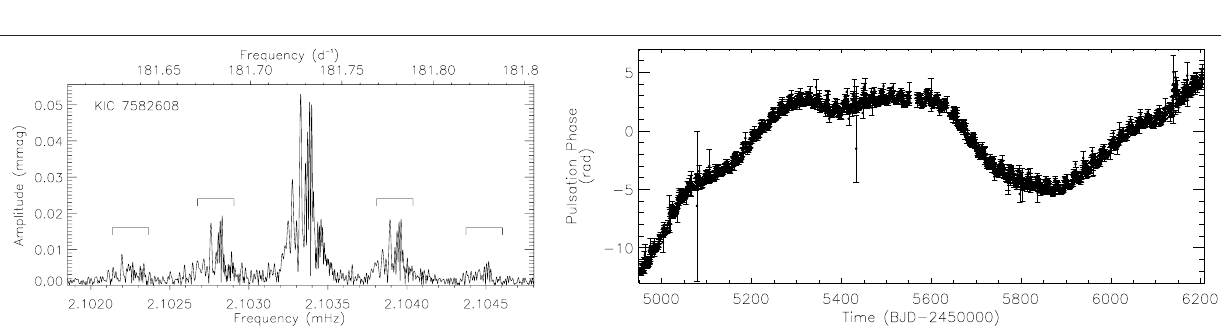
FIGURE 1 | HR diagram showing the location of the roAp stars where T eff and luminosity estimates are available. The stars discussed here, which have been observed by Kepler , are shown by the red stars. The blue lines mark the extent of the theoretical instability strip as calculated by Cunha (2002). A selection of non-oscillating Ap stars are shown by dots. The evolutionary tracks, in solar masses, are from Bertelli et al. (2008). A representative error bar is shown in the lower left corner.